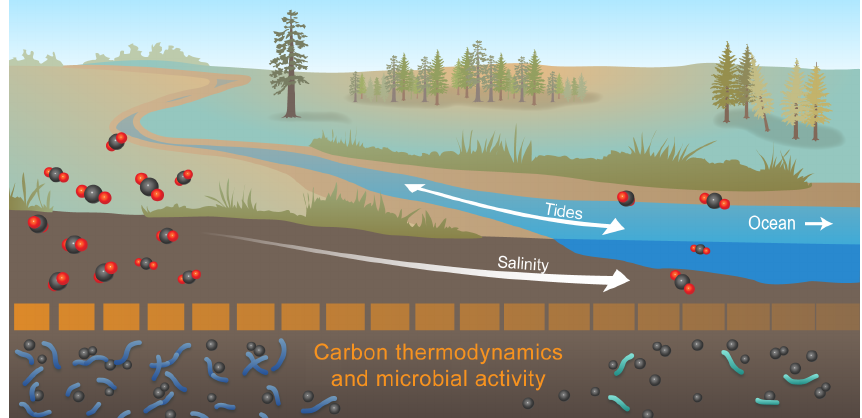
Figure 6. Conceptual model summarizing the key outcome of our study: microbial activity at high salinity may be depressed by thermo- dynamically less-favorable C. Collectively, our data revealed that organic C thermodynamic favorability, heteroatom content, and number of biochemical transformations all decreased with increasing salinity. This suggests that microbial activity was lower at higher salinity, and we hypothesize that this was due to lower thermodynamic favorability of organic C. To evaluate generality, the salinity-associated gradients shown here need to be evaluated across coastal watersheds and mechanistically understood, as they have implications for contemporary and future C cycling in coastal watersheds experiencing hydrologic disturbances (e.g., sea level rise and storm